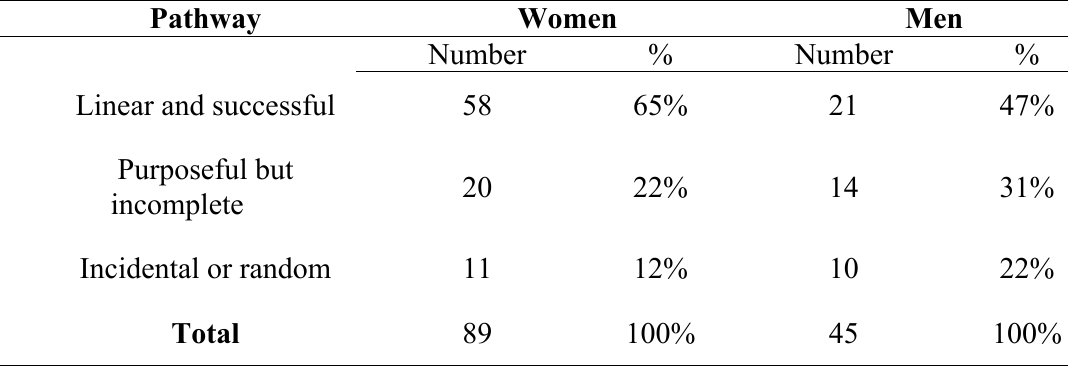
Table 2 : Gender and learning pathways Pathway Women Men Number % Number % Linear and successful 58 65% 21 47% Purposeful but 20 22% 14 31% incomplete Incidental or random 11 12% 10 22% Total 89